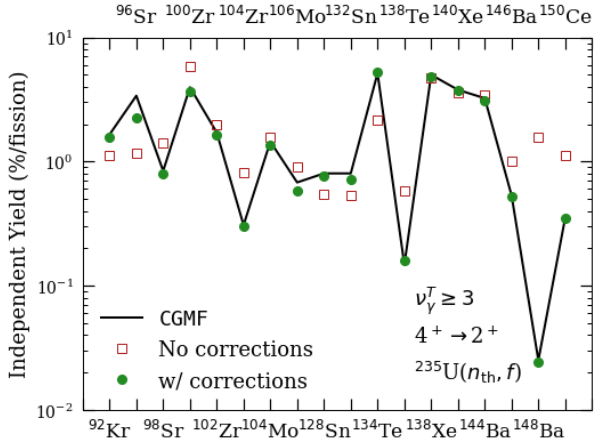
Figure 4. (Color online) Inferred yields for several even-Z even-A fission products from 235 U( n th , f ) using a single-gate on the 4 + → 2 + transition. Open (red) squares denote a simple photopeak area sum accounting for a typical [24] Ge detector resolution and a total γ -ray multiplicity cut of ν T (green) circles apply the average corrections over the three CGMF calculations (see text) to the photopeak sum results. The line shows the ‘true’ fission product yields sampled by CGMF